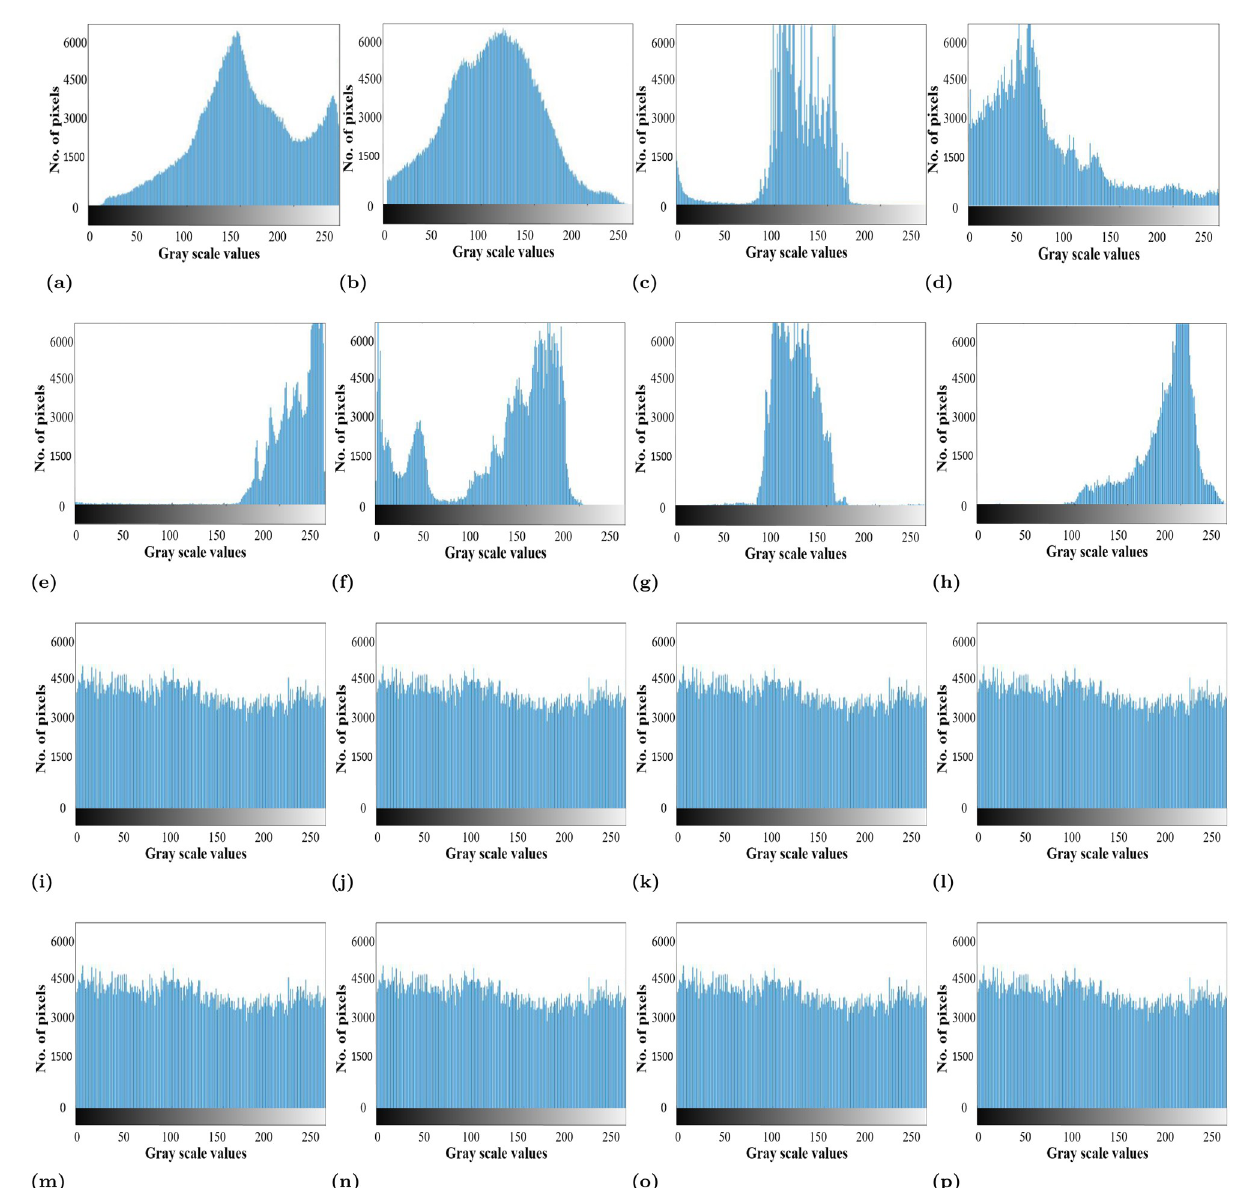
Fig 9. Histograms of plaintext images and the histogram of the corresponding enciphered images.